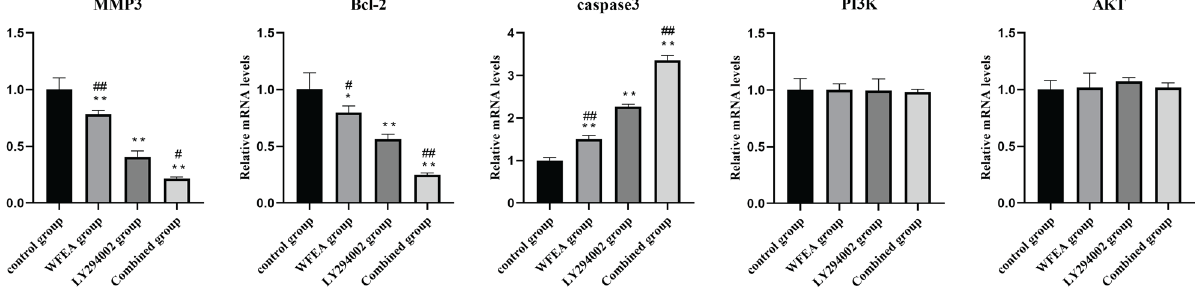
Figure 10. Effects of WFEA on the mRNA expression of related factors in the PI3K-AKT signaling pathway. * p < 0.05 and ** p < 0.01 compared with blank group, # p < 0.05 and ## p < 0.01 compared with LY294002 group.